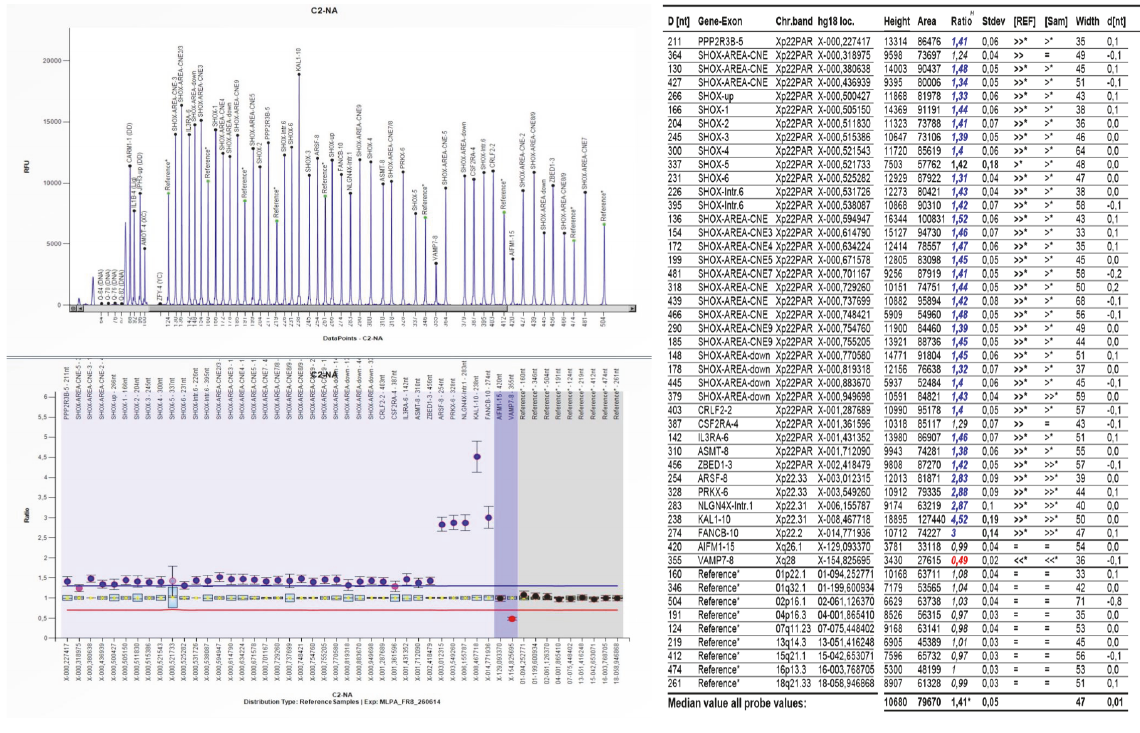
Figure 5: Multiple ligation-dependent probe amplification (MLPA) analysis was performed using a SALSA MLPA P018-G1. Reference Kit (MRC-Holland, Amsterdam, The Netherlands) according to the manufacturer’s instruction. The MLPA data analysis was performed using Coffalyser. To right Coffalyser sheet showing the ratios calculated for each probe. A value below 0.7 or above 1.3 is regarded as indicative of a heterozygous deletion (copy number change from two to one allele) or duplication (copy number change from two to three or more alleles), respectively. This kit contains probes for each exon of SHOX , as well as probes upstream and downstream of SHOX , where SHOX regulatory elements are located (CNE). Furthermore, several probes in the X-specific region of the X chromosome were included to characterize large deletions. Finally, nine autosomal reference probes were included for